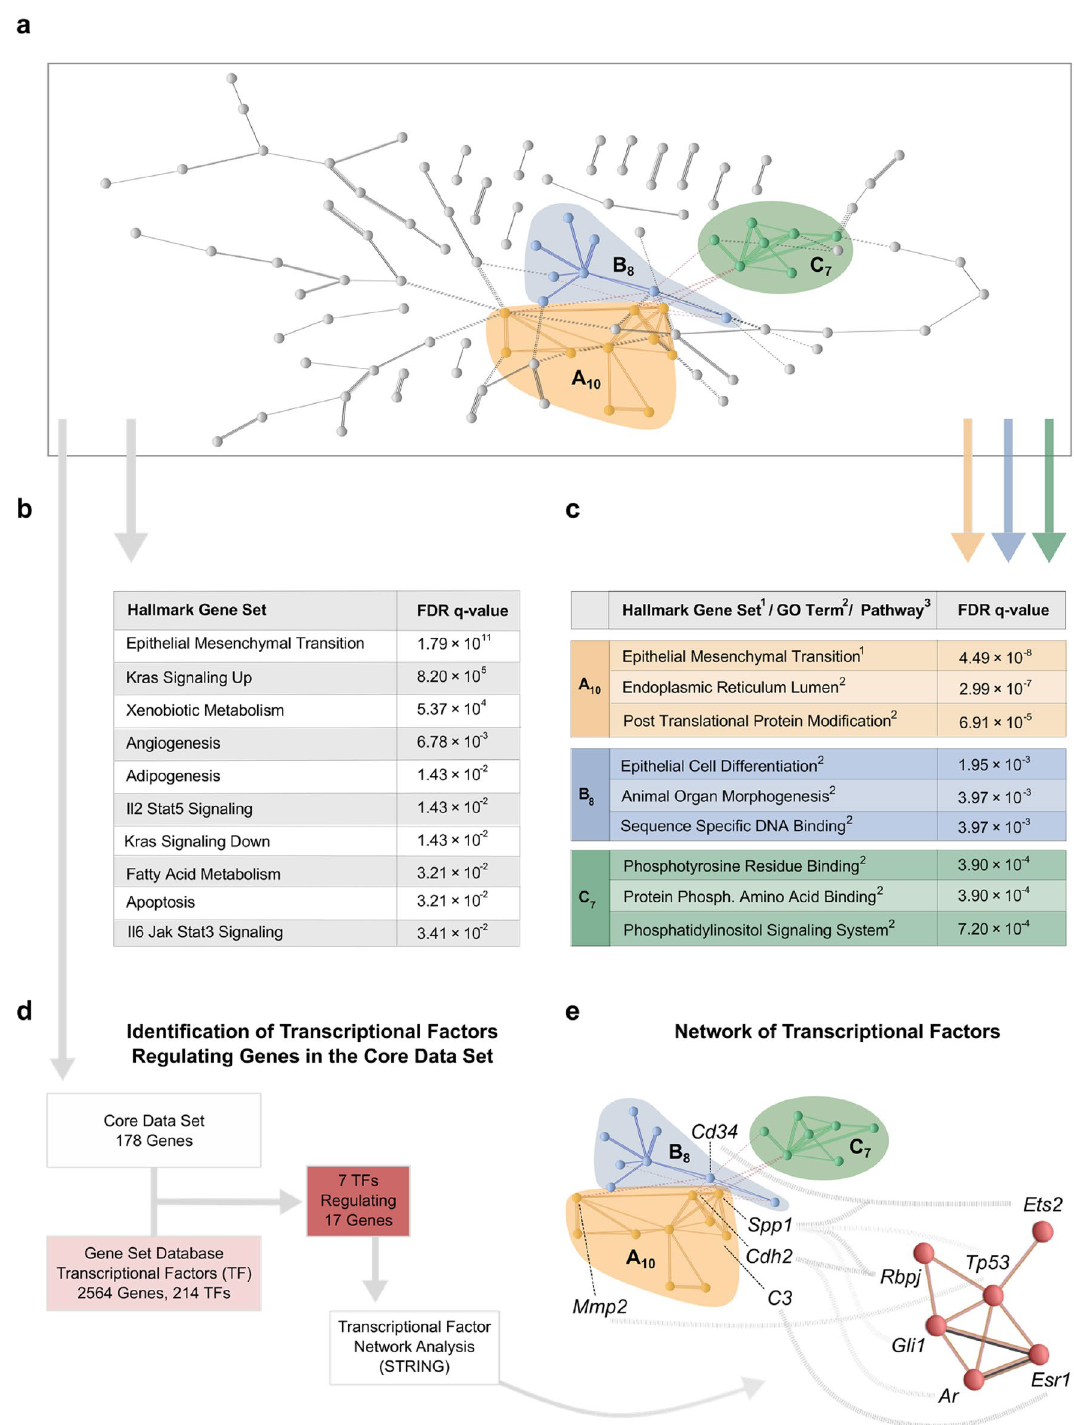
Figure 4. Function-based mapping of CD 178 identified ADPKD-related protein networks. ( a ) CD 178 was used as input for STRING network analysis 37 . No annotations were available for 2610203C20Rik and 6330403L08Rik. Application of the k-means algorithm to CD 178 revealed 3 distinct clusters: A with 10 proteins (A 10 ); B with 8 proteins (B 8 ); and C with 7 proteins (C 7 ; total = ABC 25 ). ( b ) and ( c ) to facilitate interpretation of the observed clusters, gene set enrichment analysis (GSEA) was applied to both CD 178 and ABC 25 (FDR < 0.05). ABC 25 genes were subjected to an extended analysis, comprising hallmark gene sets, gene ontology (GO) analysis, transcription factor target analysis and evaluation of the Kyoto Encyclopedia of Genes and Genomes (KEGG) 42,96–98 . See Table S7 for full results. ( d ) To elucidate CD 178 transcriptional regulation, ShinyGO and GeneSetDB meta-databases were queried (FDR < 0.05) 41,42 . This revealed a total of 17 CD 178 genes regulated by 7 trancriptional factors (TF 7 ). ( e ) 6 of 7 TF 7 were shown to form a k-means based cluster. Also, ABC 25 identified several regulatory cascades: 5 ABC 25 genes (Cd34, Spp1, Cdh2, C3 and Mmp2) were linked to 6 of the TF 7 (Ar, Esr1, Ets, Gli1, Rbpj, Tp53). Spp1 and Cdh2 were regulated by more than one TF 7 , whereas Ets2, Rbpj and Tp53 regulated more than one ABC 25